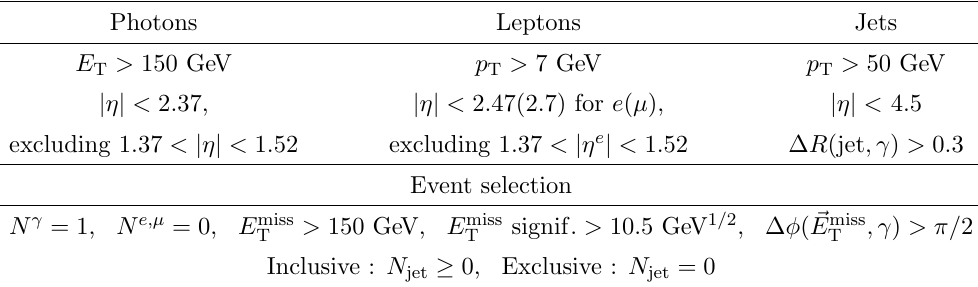
Table 1 . De(cid:12)nition of the (cid:12)ducial region. The object selection is presented in the top part of the table, while the event selection is described in the bottom